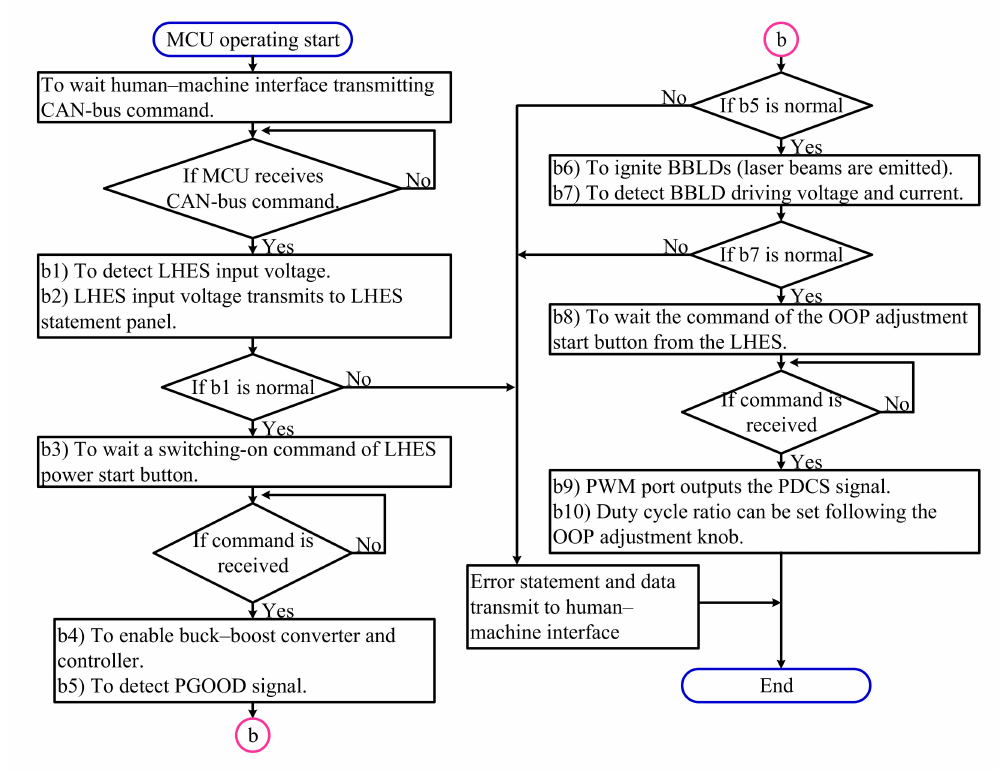
Figure 6. Software flowchart of LHES microcontroller unit (MCU)